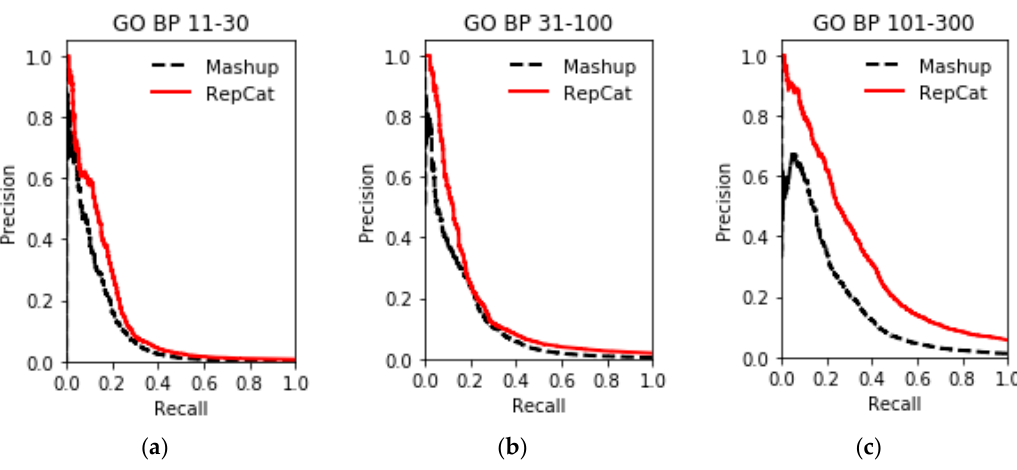
Figure 4. Performance Comparison of GO BP function prediction on human datasets between ReprsentConcat and Mashup. ( a ): GO BP 11-30; ( b ): GO BP 31-100; ( c ): GO BP 101-300.